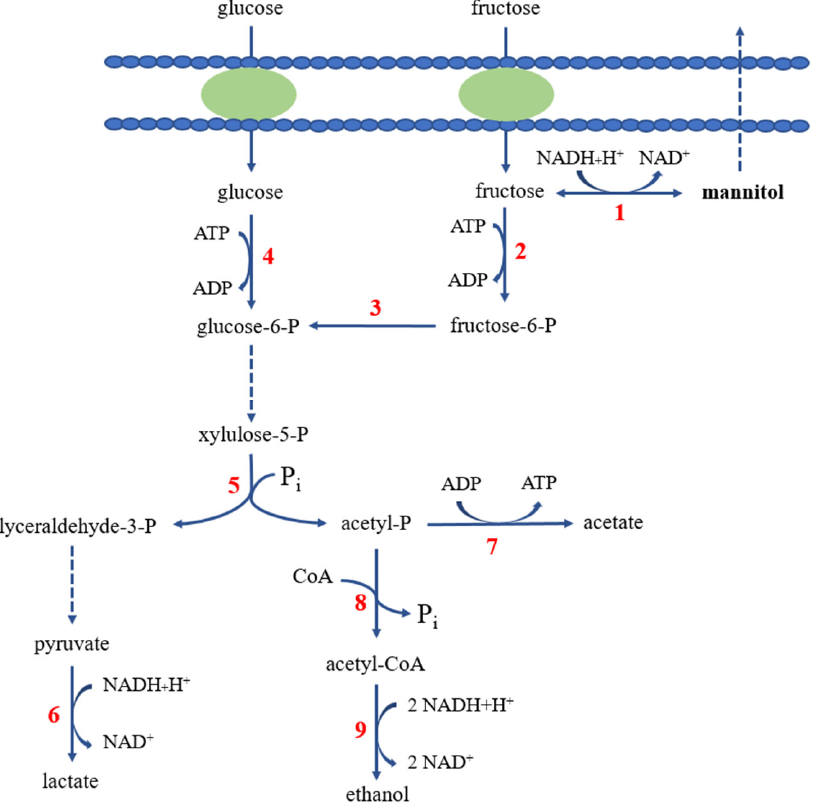
Figure 3. Mannitol production from fructose in heterolactic fermenters such as Leuconostoc species. Pathway for fructose utilization is also shown. 1, mannitol dehydrogenase; 2, fructokinase; 3, glucose phosphate isomerase; 4, glucokinase; 5, phosphoketolase; 6, lactate dehydrogenase; 7, acetate kinase; 8, phosphate acetyltransferase; 9, acetaldehyde dehydrogenase and alcohol dehydrogenase [76]. Figure 3 was modified from Figure 2 of reference [76] with the permission from Elsevier at Sep. 9, 2021 (5144670406141).